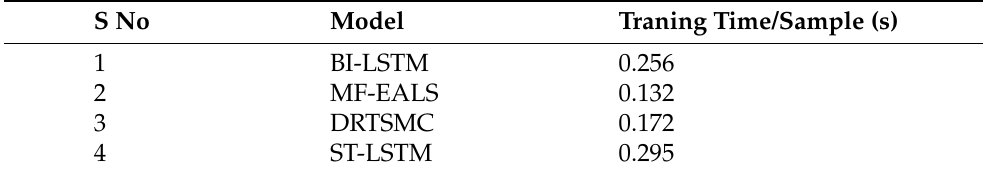
Table 5. Testing time for data recovery approaches.